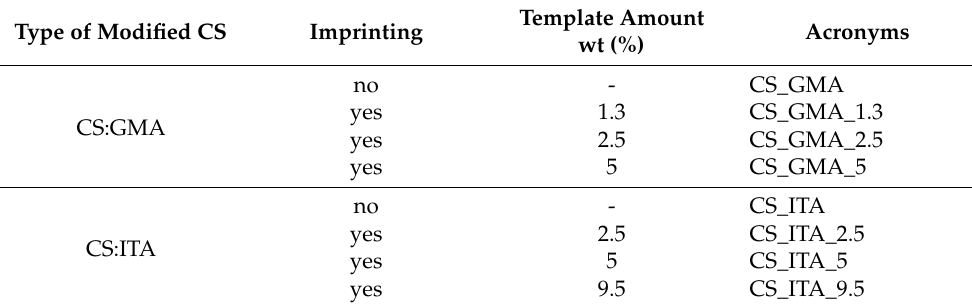
Table 1. Acronyms of CS_GMA and CS_ITA MIPs and